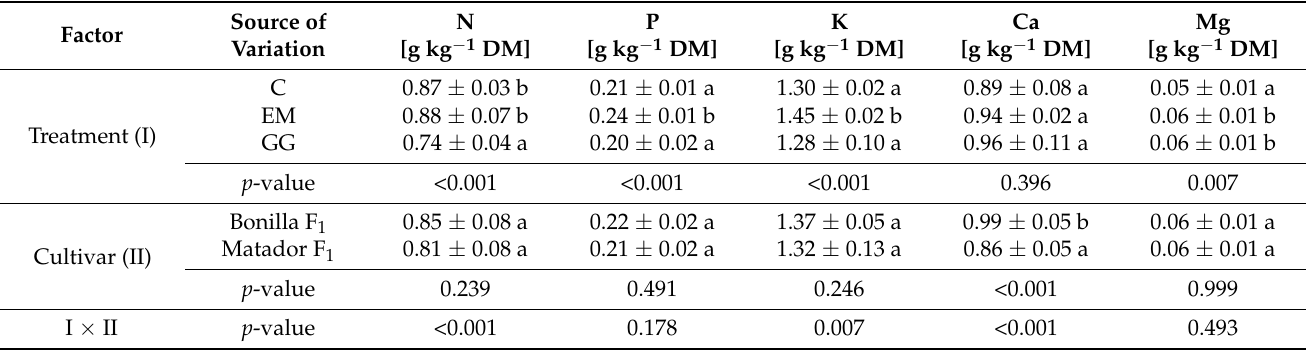
Table 6. Macronutrient content of shallot